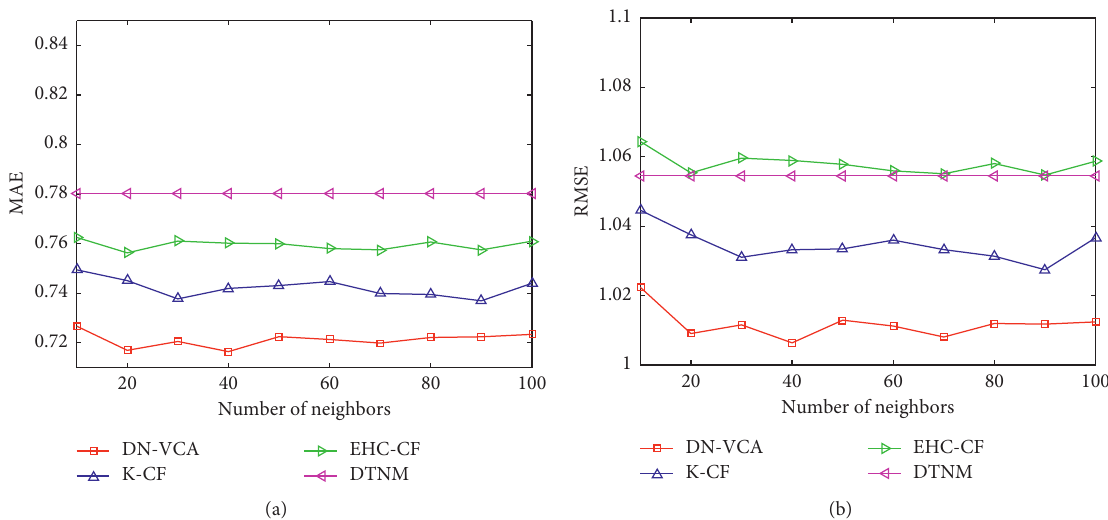
Figure 9: Movielens. (a) Comparison results of MAE of four algorithms. (b) Comparison results of RMSE of four algorithms.